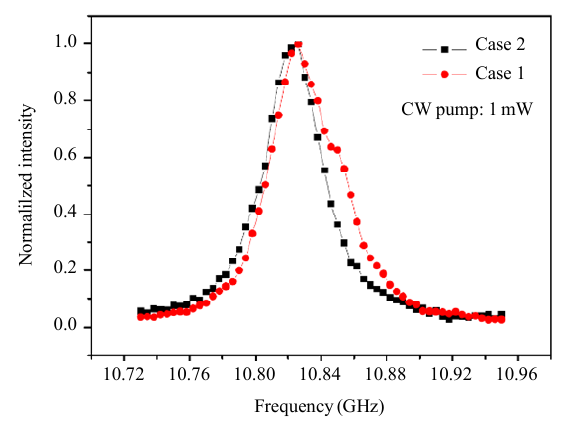
Fig. 8 Measured Brillouin loss spectra with the non-local effect (Case 1) and without non-local effect (Case 2)